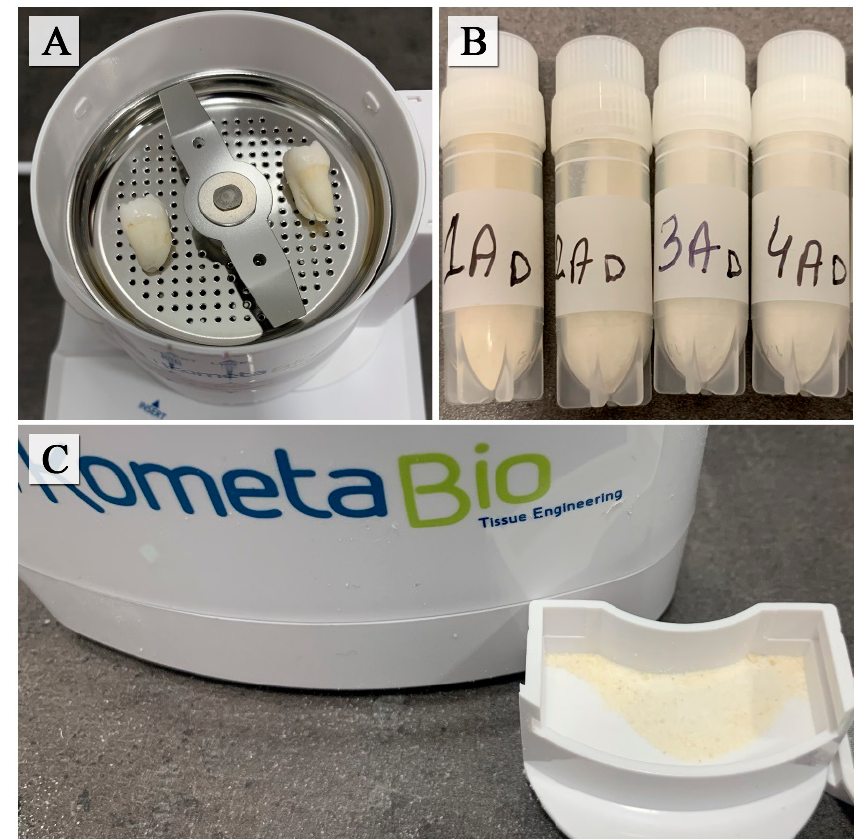
Figure 6. Human teeth inside the “Smart Dentin Grinder” chamber ( A ), prepared samples ( B ), compartment of particles ( C ).